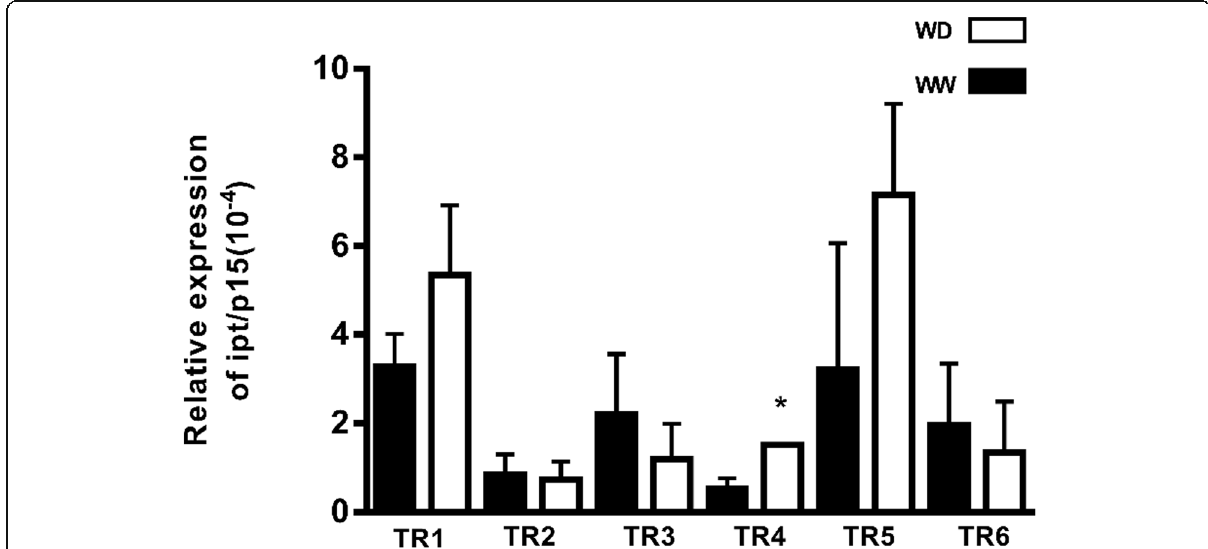
Fig. 4 Relative expression of IPT /TaRP15 of transgenic events measured by qRT-PCR. The events TR1, TR2, TR3, TR4, TR5, and TR6, measured by qRT-PCR 7 days post-anthesis under well-watered (WW) and water-deficit (WD) conditions. Mean ± S.D., n = 4 for each data point. Values expressed at 10 − 4 . * p <0.05